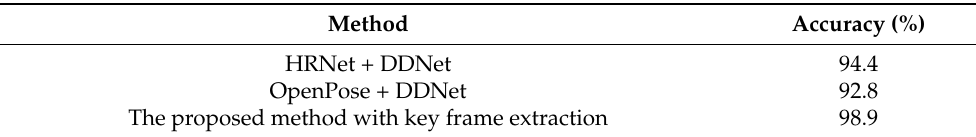
Table 3. Performance evaluation of different methods for action recognition on the self-collected HNH